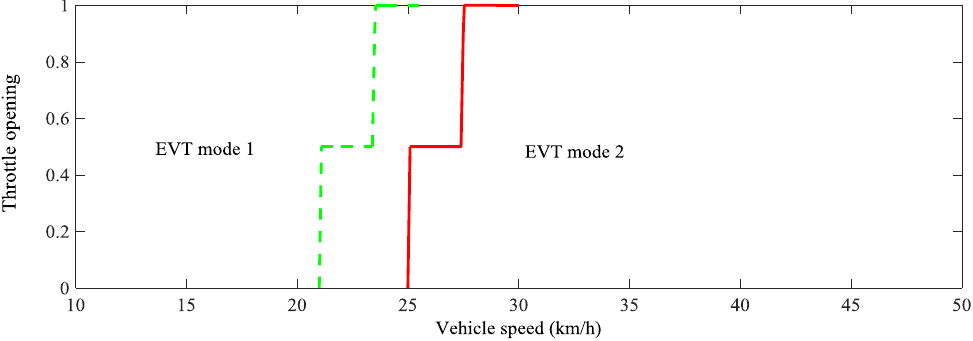
Figure 13. Economic shift schedule of the hybrid HDV with PST.